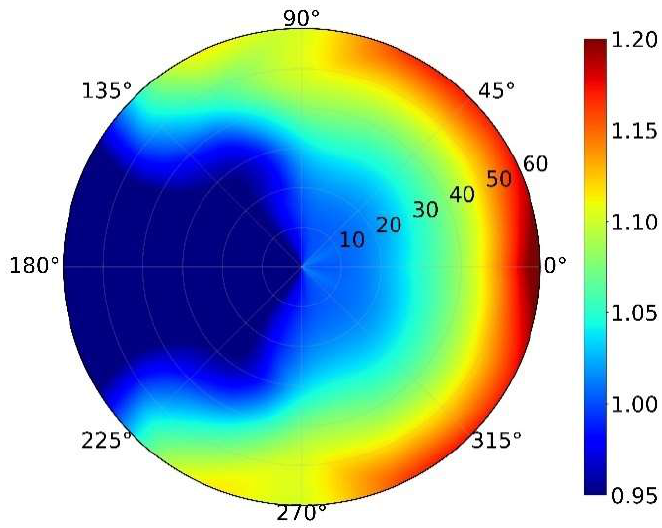
Figure 10. The ANIF values of gray target from BRDF measurement.